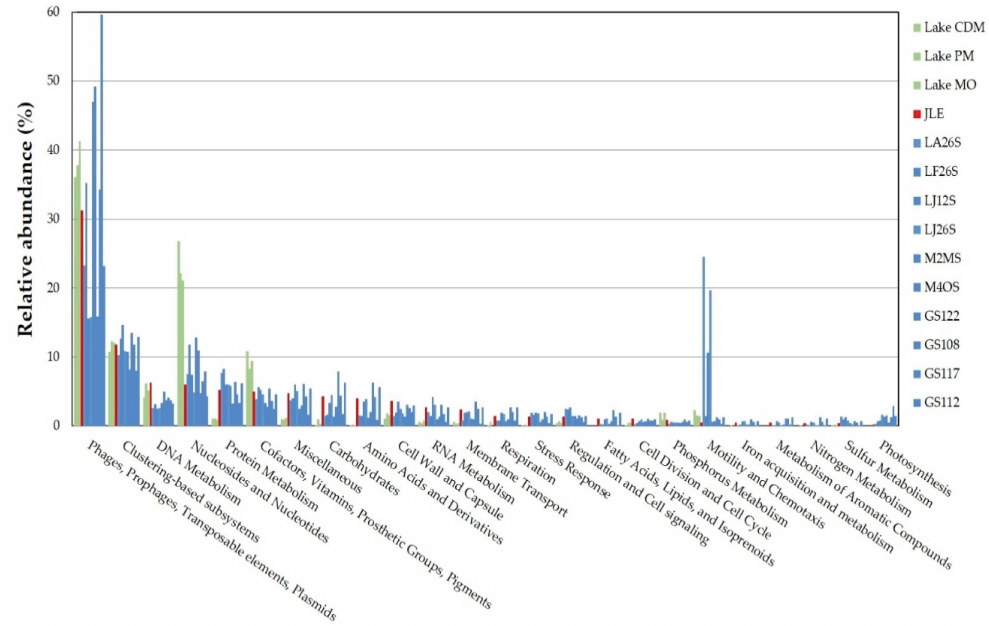
Figure 4. Comparison of metabolic subsystems of the JRE virome with other aquatic viromes. The coding sequences were compared with SEED database using subsystems in MG-RAST. Metabolic subsystems from the JRE virome are colored by red. Green represents functional categories from temperate lakes (stations CMD, PM, and MO) [14]. Blue represents functional categories from the Pacific Ocean (stations LA26S, LF26S, LJ12S, LJ26S, M2MS, and M4OS) [31], and the Indian Ocean (stations GS122, GS108, GS117, and GS112)